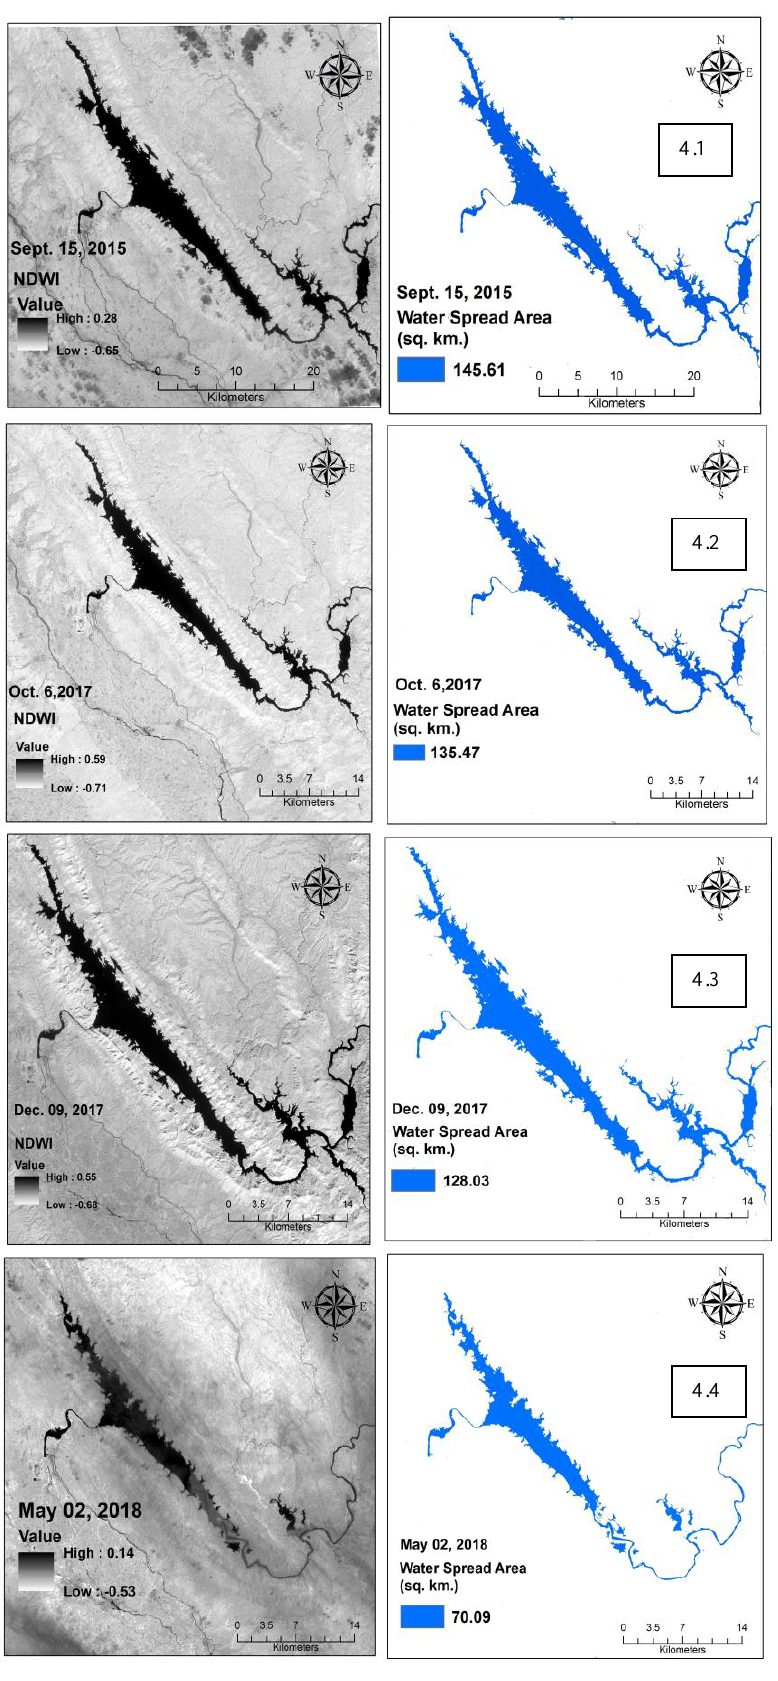
Fig. 4.1 to 4.4 NDWI map of different dates obtained from Google Earth Engine and corresponding masked water